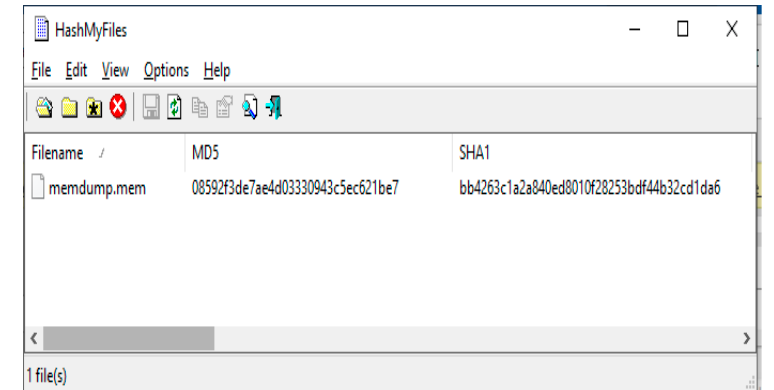
Figure 14. Results of verification. 